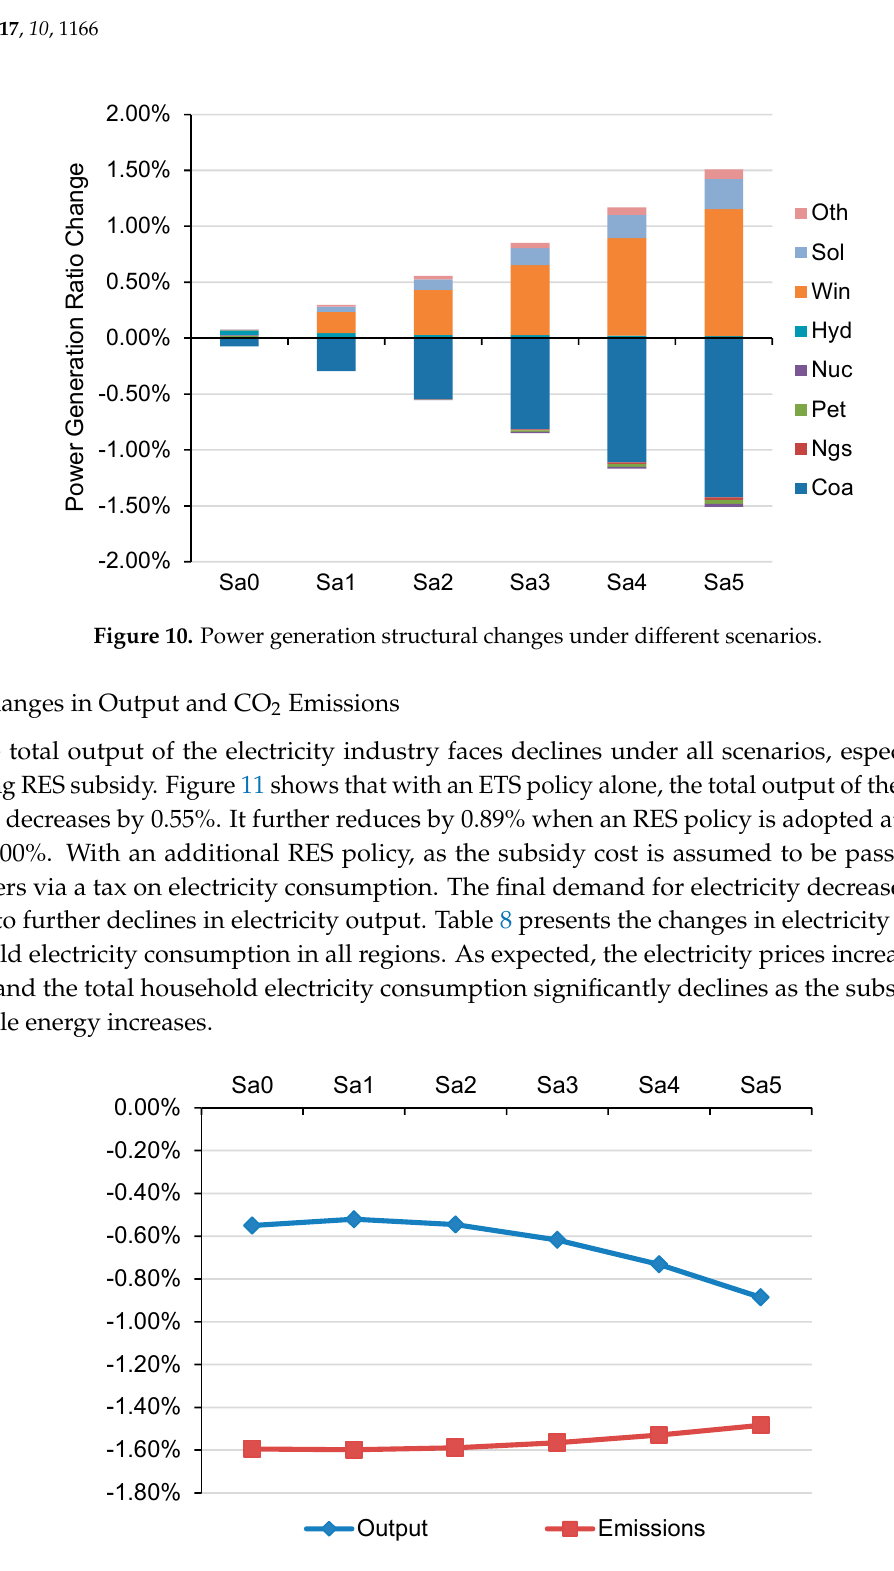
Figure 11. Changes in output and CO 2 emissions of electricity industry.